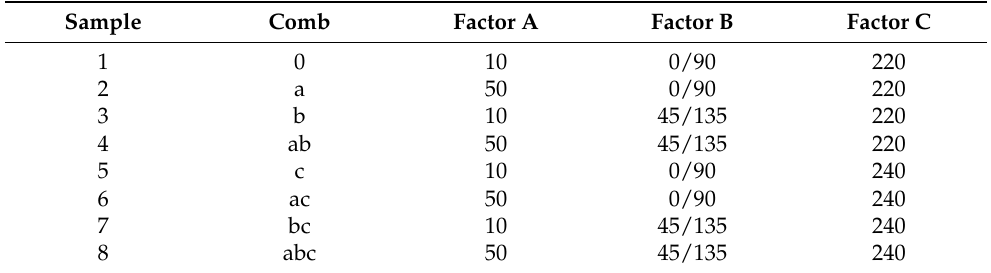
Table 2. Case study design of experiments (DOE) table. This case study used a full-factorial 2 3